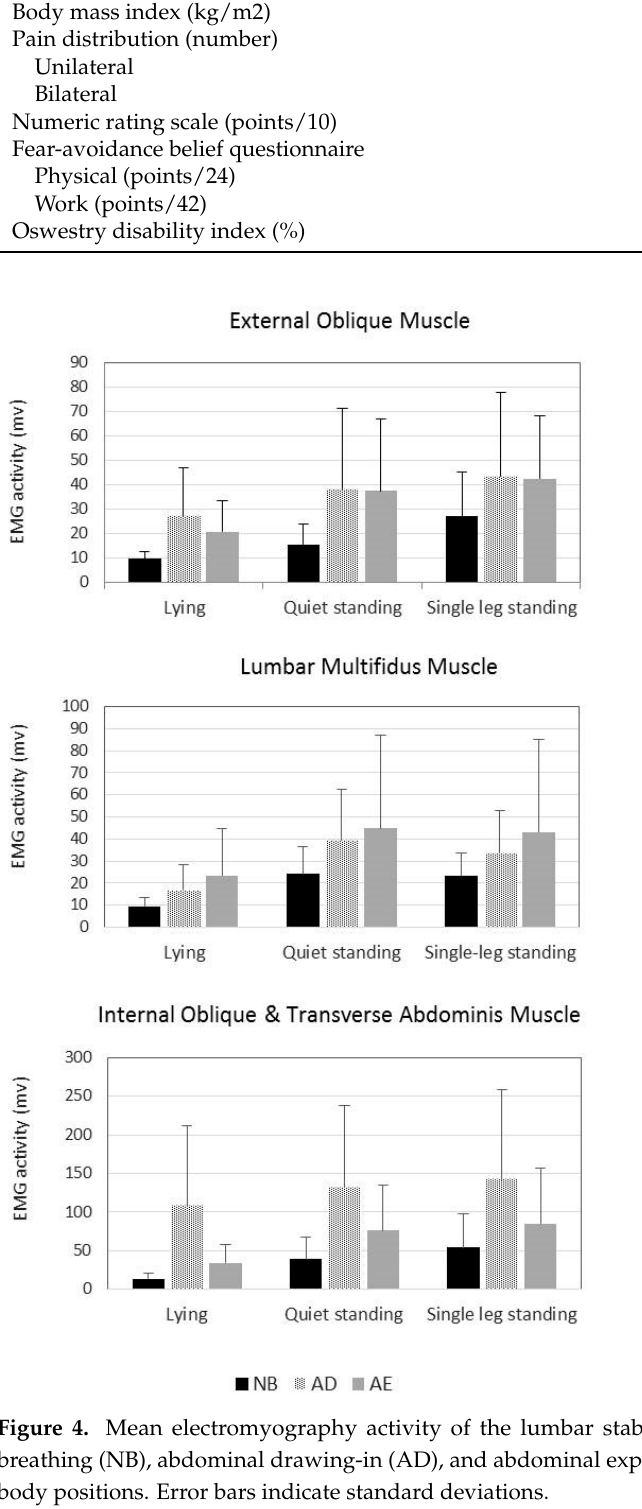
Figure 4. Mean electromyography activity of the lumbar stabilization muscles during natural breathing (NB), abdominal drawing-in (AD), and abdominal expansion (AE) strategies in different body positions. Error bars indicate standard deviations.